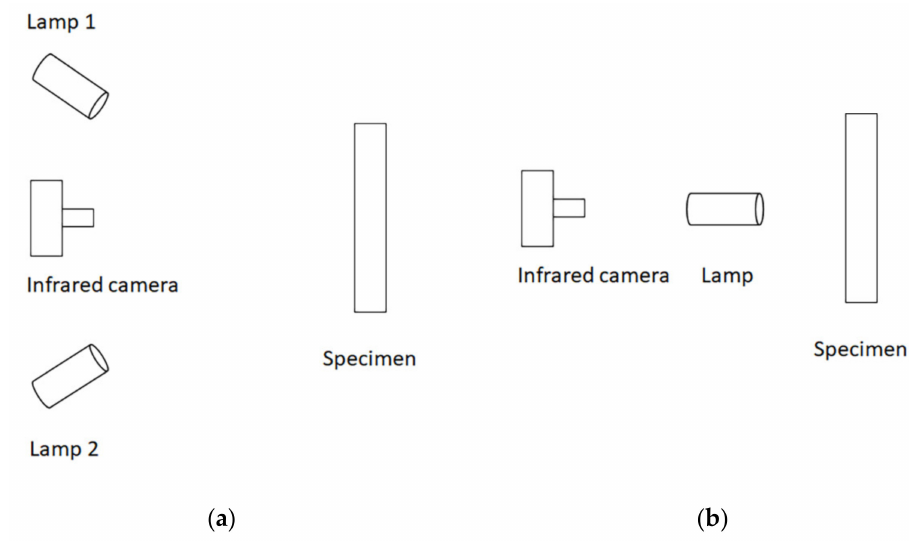
Figure 2. Thermographic testing: ( a ) first scheme (1st test), and ( b ) second scheme (2nd